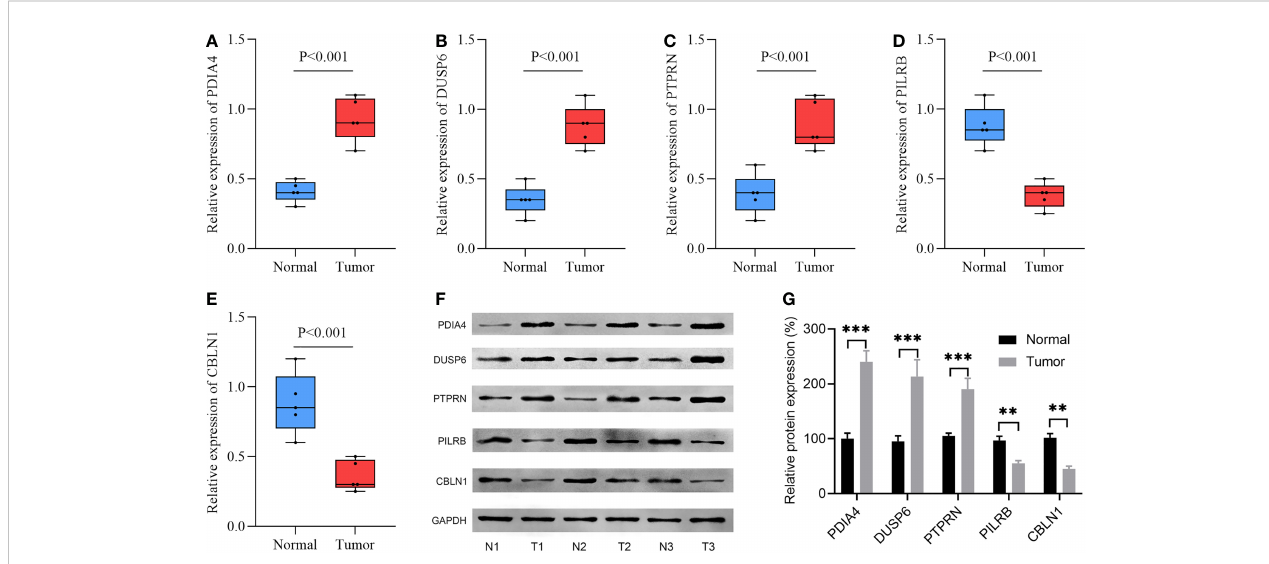
FIGURE 8 The expression levels of 5 model-related genes in GBM tissues and corresponding normal tissues were validated by RT-qPCR and WB. (A – E) RT-qPCR validated the mRNA expression levels of genes. (F) WB assay validated the protein expression levels of genes. (G) Relative density is determined by the densitometry of the blots. N, normal; T, tumor. ** p < 0.01, *** p < 0.001 vs. normal